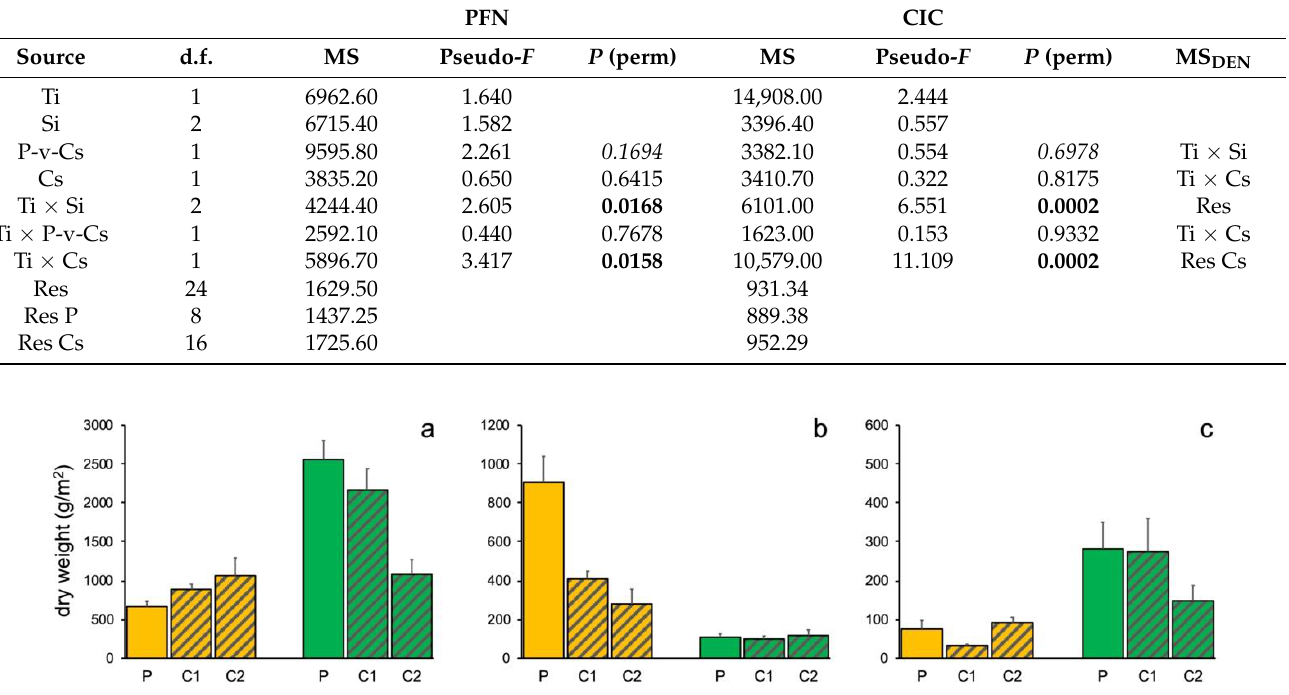
Table 3. Results of asymmetrical PERMANOVA testing for differences between P and Cs in biomass of invertebrate assemblages associated to E. amentacea in both the investigated MPAs (PFN and CIC). The analysis is based on Bray–Curtis dissimilarities (untransformed data) and each test was performed using 5000 random permutations. Significant tests are provided in bold. Denominators for tests (MS DEN ) were also indicated.